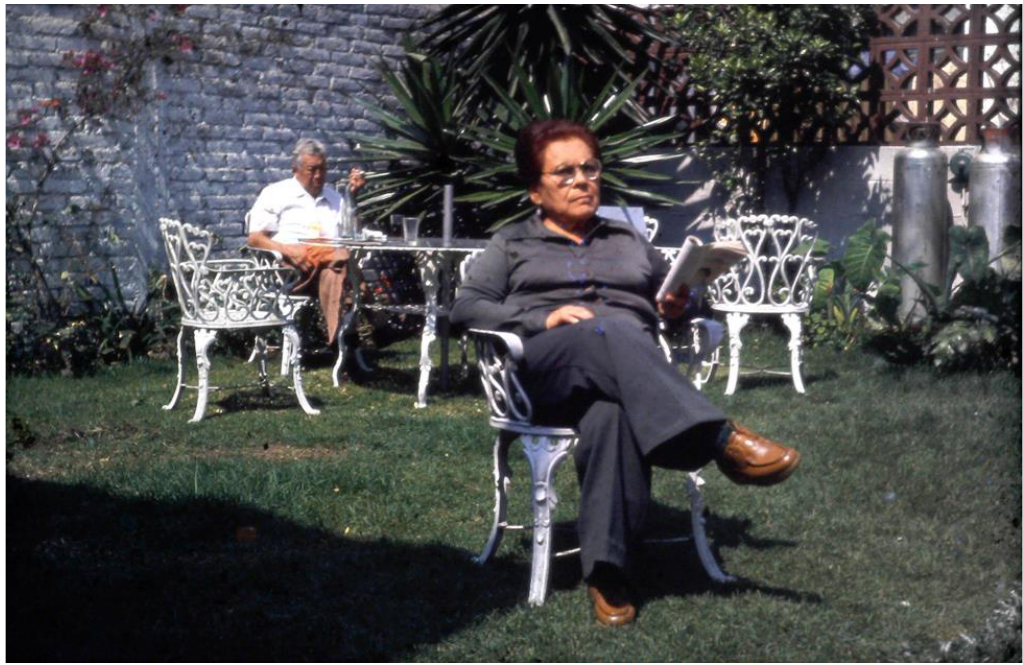
Figure 1: Chucho and Manuela sitting in the family garden. Courtesy: Rafael Gonzalez Melendrez, circa 1980s Road